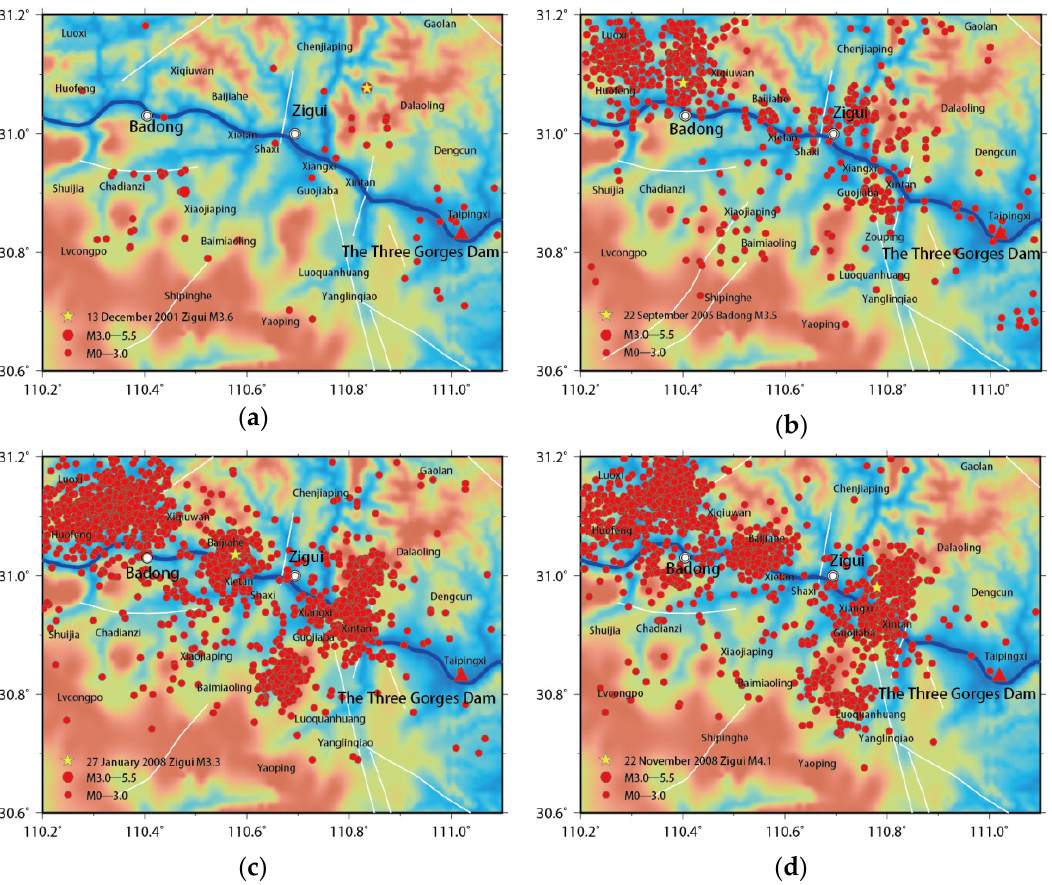
Figure 5. Spatial distribution of seismicity in the study area during the impoundment of the Three Gorges Project (January 2001–December 2009, M ≥ 0). ( a ) Before the water impoundment; ( b ) 135 m stage; ( c ) 156 m stage; ( d ) 175 m experimental stage .